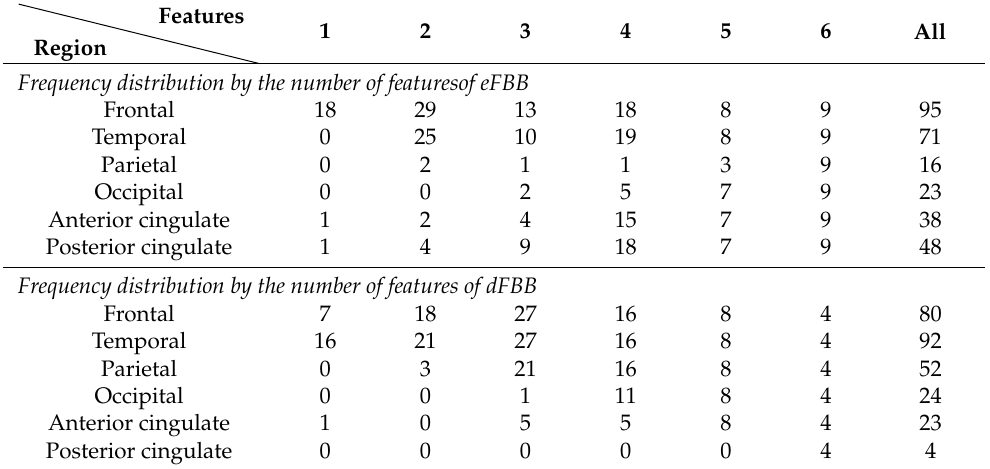
Table 5. Frequency distribution according to the number of selected features in a single